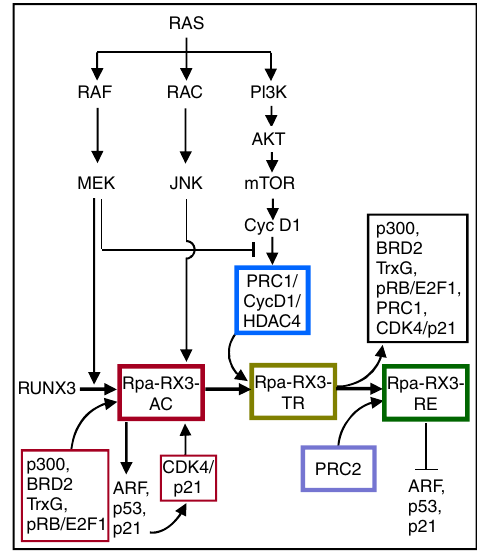
Fig. 6 The roles of the RAS pathway in regulating the R-point transition. The RAS – RAF – MEK pathway facilitates formation of Rpa-RX3-AC and inhibits formation of the PRC1 – Cyclin D1 – HDAC4 complex. The RAS – RAC – JNK pathway activates CDK4 within Rpa-RX3-AC. The RAS – PI3K pathway facilitates formation of Rpa-RX3-TR by contributing to translation of Cyclin